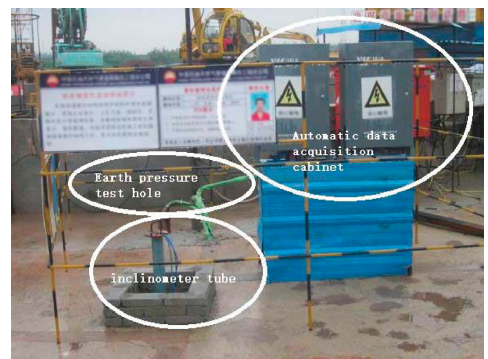
Figure 26: Layout and installation of inclined